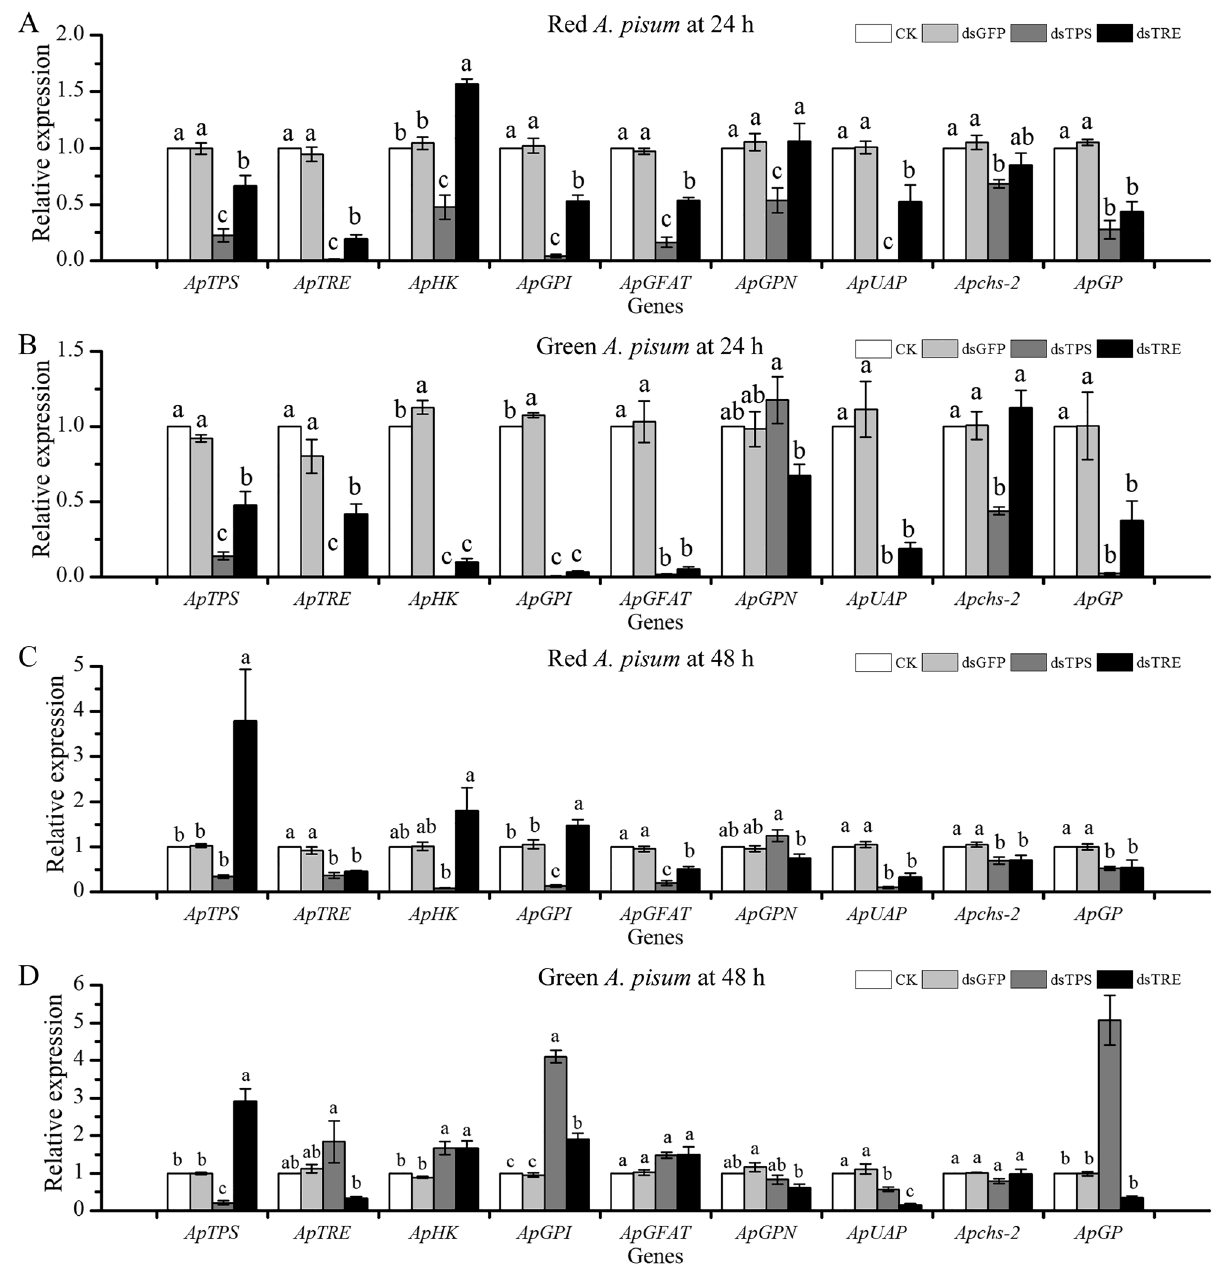
Figure 4. Effect of ApTPS and ApTRE RNAi treatments on the expression of the gens involved in the chitin biosynthesis. ( A ) in red morphs at 24 h, ( B ) in green morphs at 24 h, ( C ) in red morphs at 48 h, ( D ) in green morphs at 48 h. CK, the normal diet; dsGFP, the GFP-dsRNA treatment; dsTPS, the TPS-dsRNA treatment; dsTRE, the TRE-dsRNA treatment; ApTPS , trehalose-6-phosphate synthase gene; ApTRE , trehalase gene; ApHK , Hexokinase gene; ApGPI , glucose-6-phosphate isomerase gene; ApGFAT , glutamine-fructose-6- phosphate aminotansferasr gene; ApGPN , glucosamine-6-phosphate-N-acetytransferase gene; ApUAP , UDP- N-acetyglucosamine pyrophosphorylase gene; Apchs-2 , chitin synthase gene 2; ApGP , glycogen phosphorylase gene. Each bar represents the Means ± SEM from three biological replicates and three technical replicates. The data were analyzed using one-way analysis of variance (ANOVA), followed by the Tukey–Kramer test. The mRNA expression level in the normal artificial diet group was designated as the reference control for the comparisons. The different letters above the error bars indicate significant differences ( P <